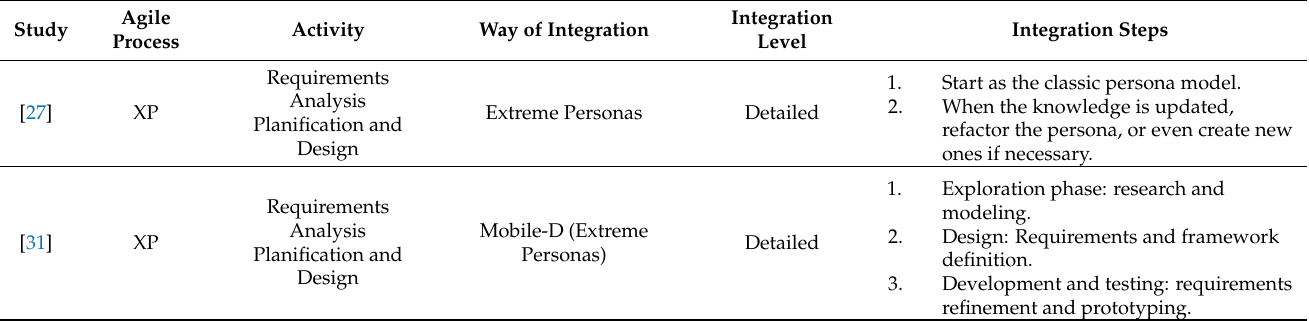
Table A4. Detailed integration method proposed by each selected primary